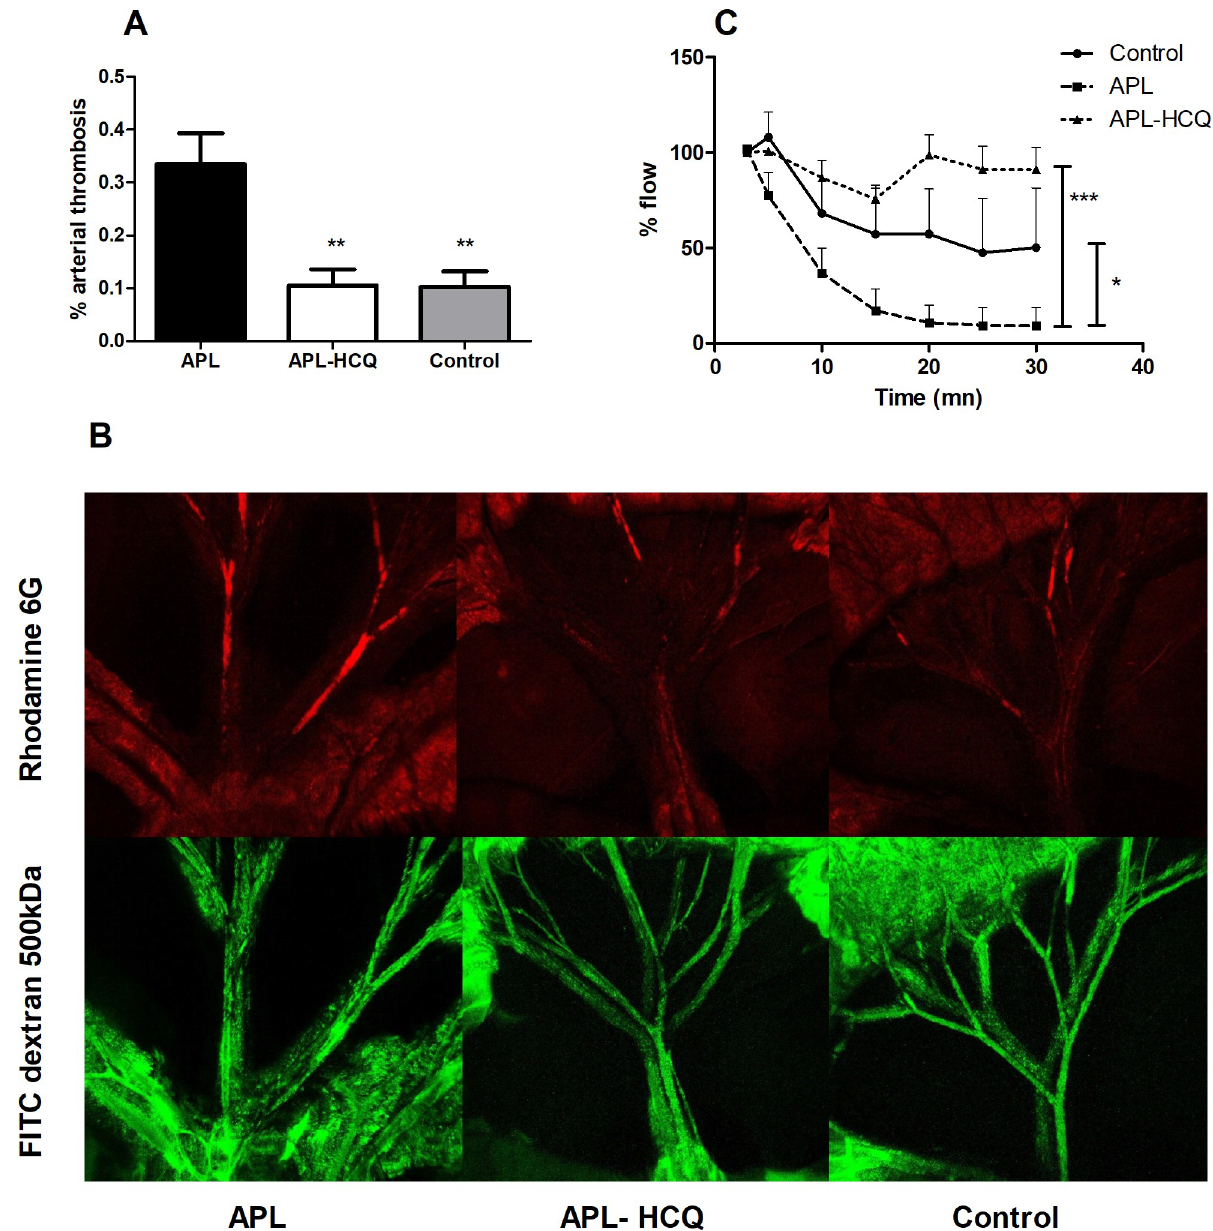
Fig 1. Effects of Hydroxychloroquine (HCQ) on in vivo thrombosis. (A) The thrombosis/arterial area ratio in control mice, or aPL mice either untreated or treated with HCQ. 30min after chemical injury (FeCl3 10%). (B) thrombosis was assessed with macroconfocal imaging. Platelets were labeled with rhodamine6G (red) and total arterial area was labeled with FITC-dextran 500kDa FITC (green) (n = 5). (C) Carotid blood flow (n = 6) measured with a flow probe in mice before and 30 min after FeCl3 injury. Values are mean ± SEM � : P < 0.05; �� : P < 0.01 ��� : P < 0.001.